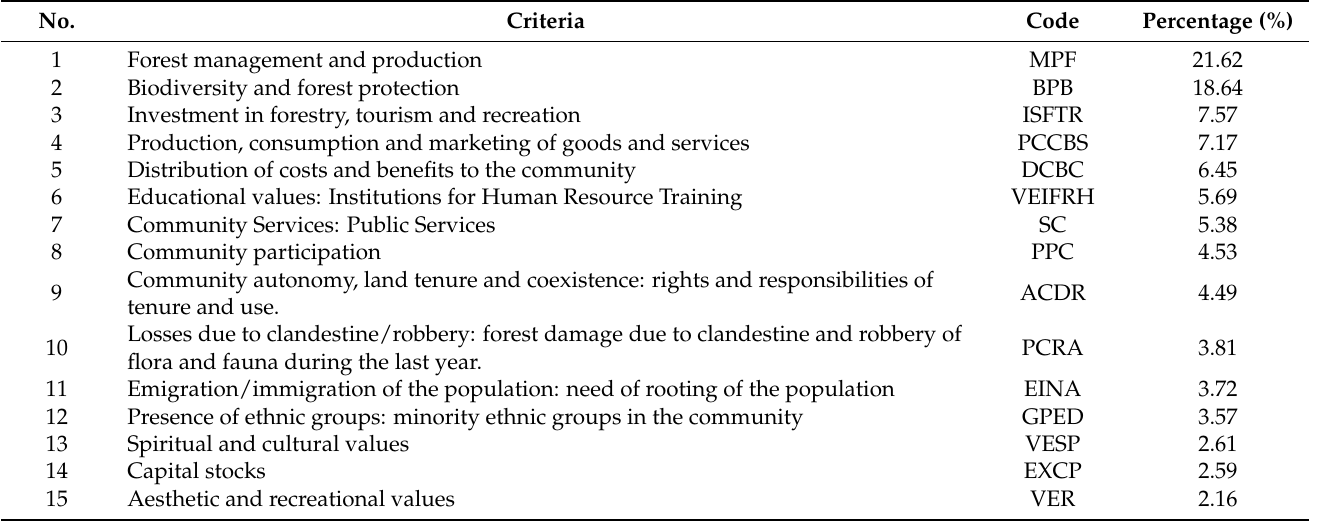
Table 3. Importance ranking in percentage of forest certification criteria assessed by the Analytic Hierarchy Process in this